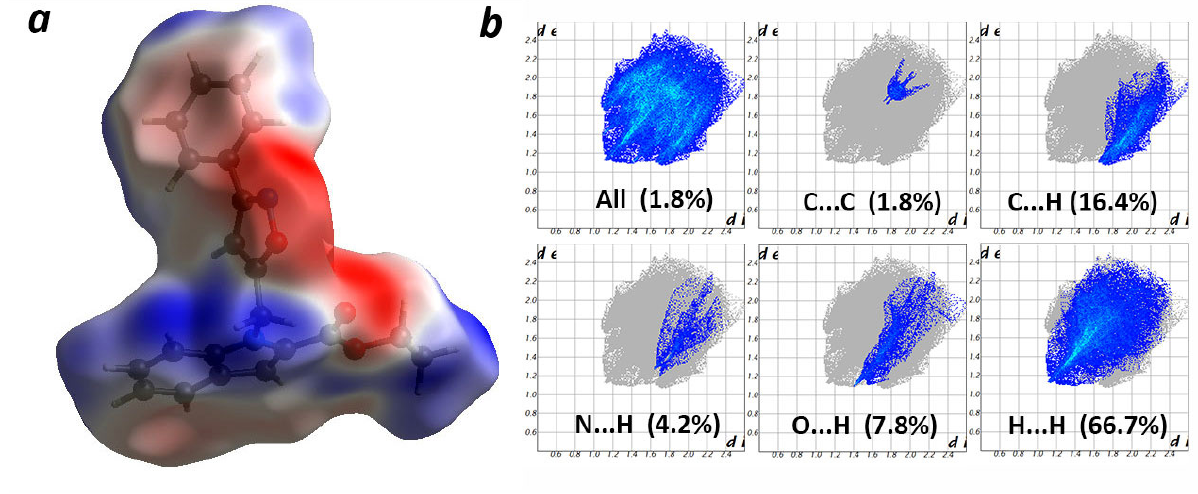
Figure 3: a) Compound (8a) mapped over the Hirschfeld surface with a scale of -0.07 a.u. (red) through 0.0 (white) to +0.04 a.u. (blue); b) Two-dimensional full fingerprint plots and decomposed fingerprint plots over the Hirschfeld surface for various intermolecular atom–atom contacts in compound (8a) . The numbers in brackets indicate the percentage contributions of each